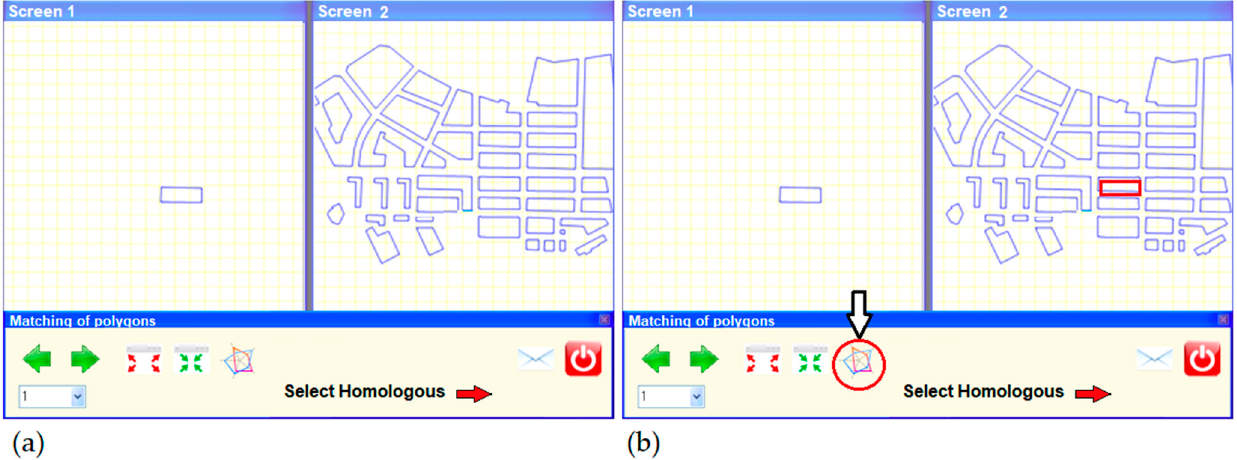
Figure 12. Graphical user interface belonging to the matching experiment. ( a ) Example of assignment without the help of the edition tools; ( b ) example of assignment using the edition tools.